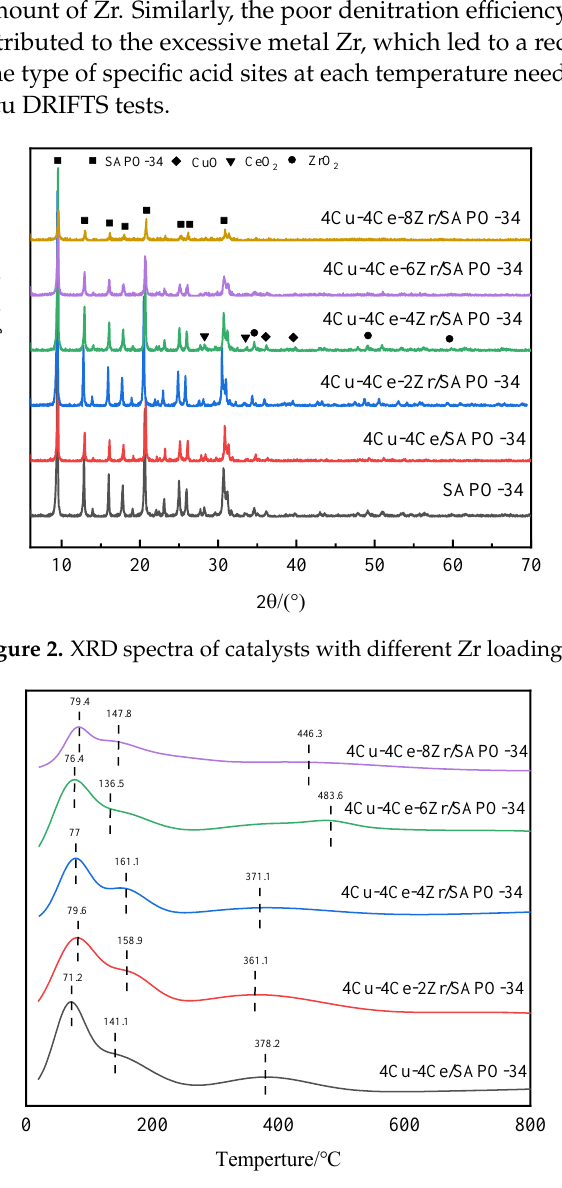
Figure 3. NH 3 -TPD spectra of catalysts with different Zr